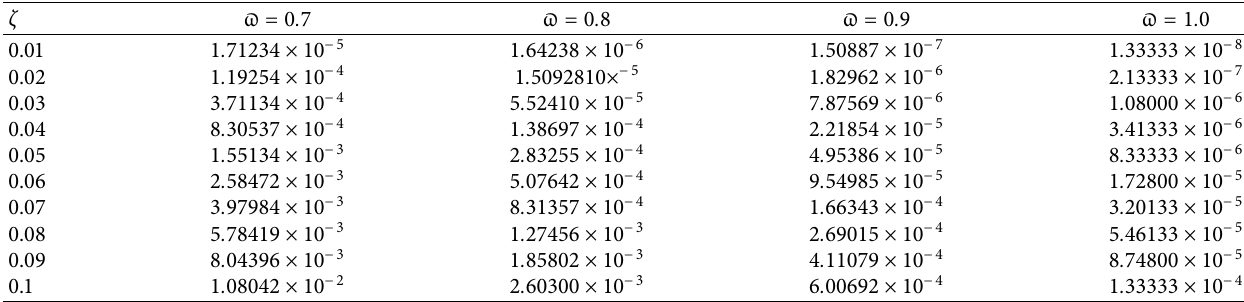
Table 5: | w 4 ( ϰ , ζ ) − w 3 ( ϰ , ζ )| of Problem 3 at diferent values of ϖ at ϰ � 0 . 002 when λ � 2 . 0 determined by LRPSM at plausible locations in the range ζ ∈ [ 0 , 0 . 1 ] .